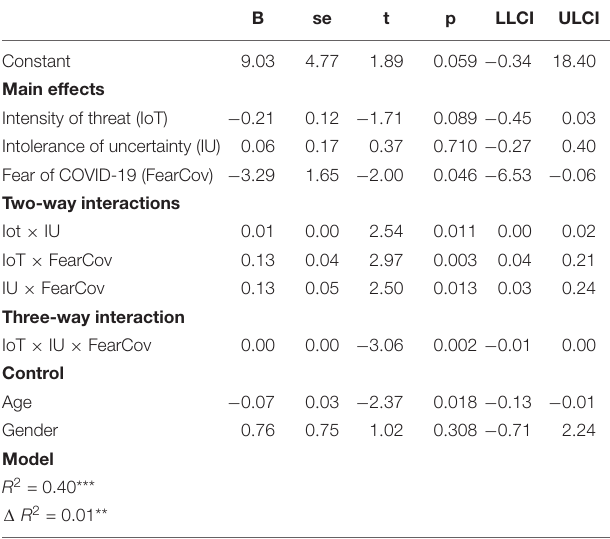
correction method revealed that they differed significantly from all other groups. In addition, difference between those who are working from home and those who are working with changed working hours was found (mean ranks are presented in Table 2 ).